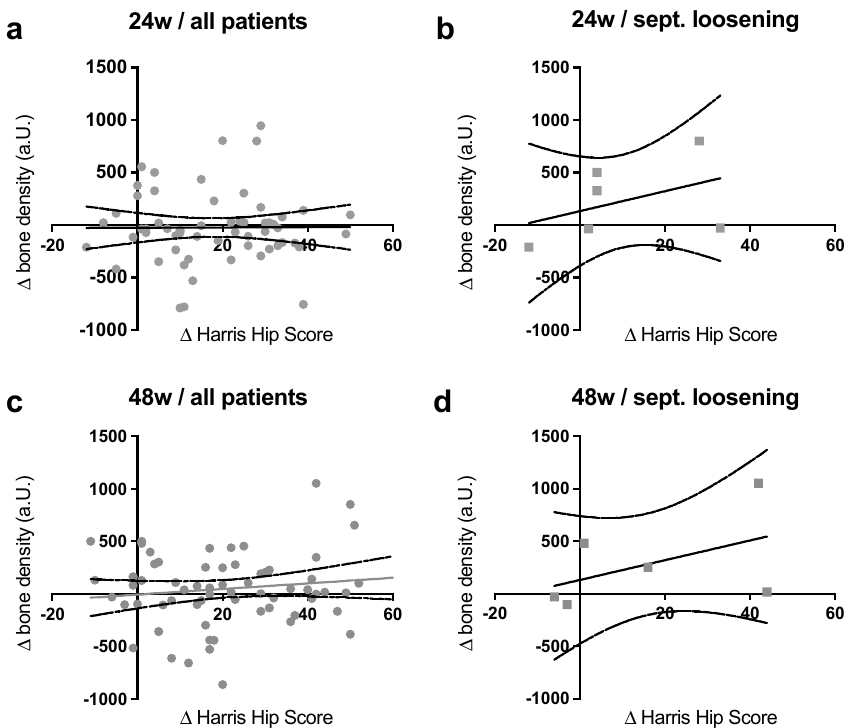
Figure 5. Relation of the average clinical and radiographic developments ( a ) of all patients after 24 weeks; ( b ) septic loosening after 24 weeks; ( c ) all patients after 48 weeks; ( d ) septic loosening after 48 weeks. Linear regressions after 24 weeks of the entire cohort depicted no correlation tendency, a visible increase after 48 weeks (but also no statistical significance), as well as a decrease in outliers. The subgroup of septic loosening, with the most significant bone change, showed a strong positive connection between the average bone density and the clinical development after 24 and 48 weeks, but, here, no significance could be proven.